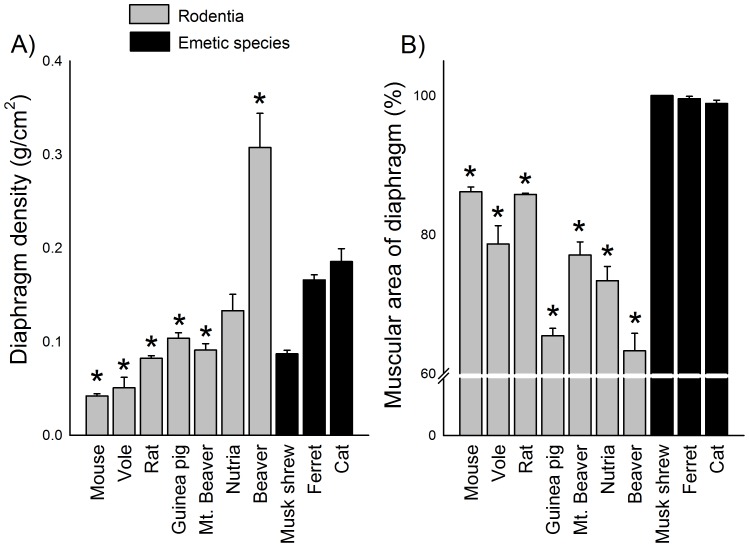
Diaphragm density and area measures.
A) Density of the diaphragm (g/cm2). B) Percentage of diaphragm area composed of muscle compared to ligament. The SEM for musk shrews is small and hidden by the vertical bar. See Figure 3 for a diagram showing the location of these measures. * = p<0.05, planned contrast, a rodent species compared to all emetic species. Data represent mean ± SEM.